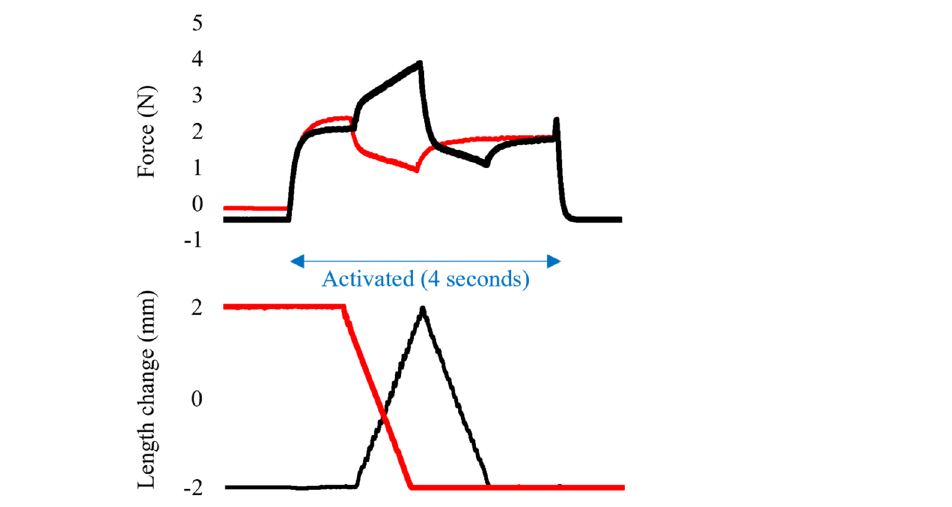
Figure 2. A representative sample of muscle force (upper panel) and muscle length (lower panel) as a function of time. The red line shows a trial of a concentric contraction with isometric preactivation (pure shortening condition) and the black line shows a trial of a concentric contraction with eccentric preactivation (SSC condition).